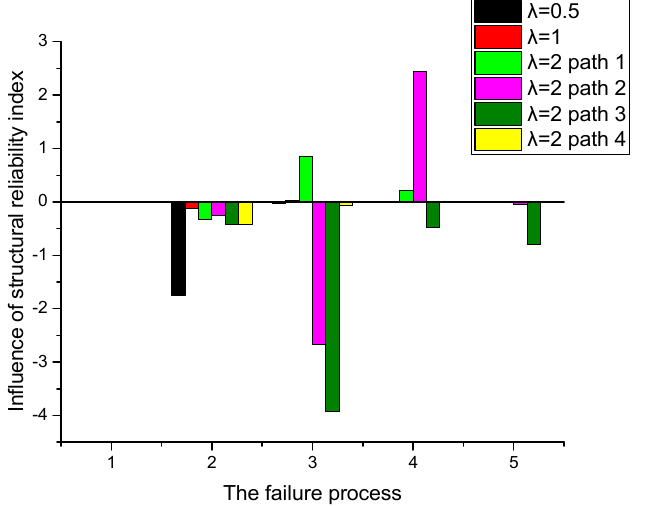
Figure 16. Impact of the structural reliability index on the subsequent failure stage of the different ent parts. parts.